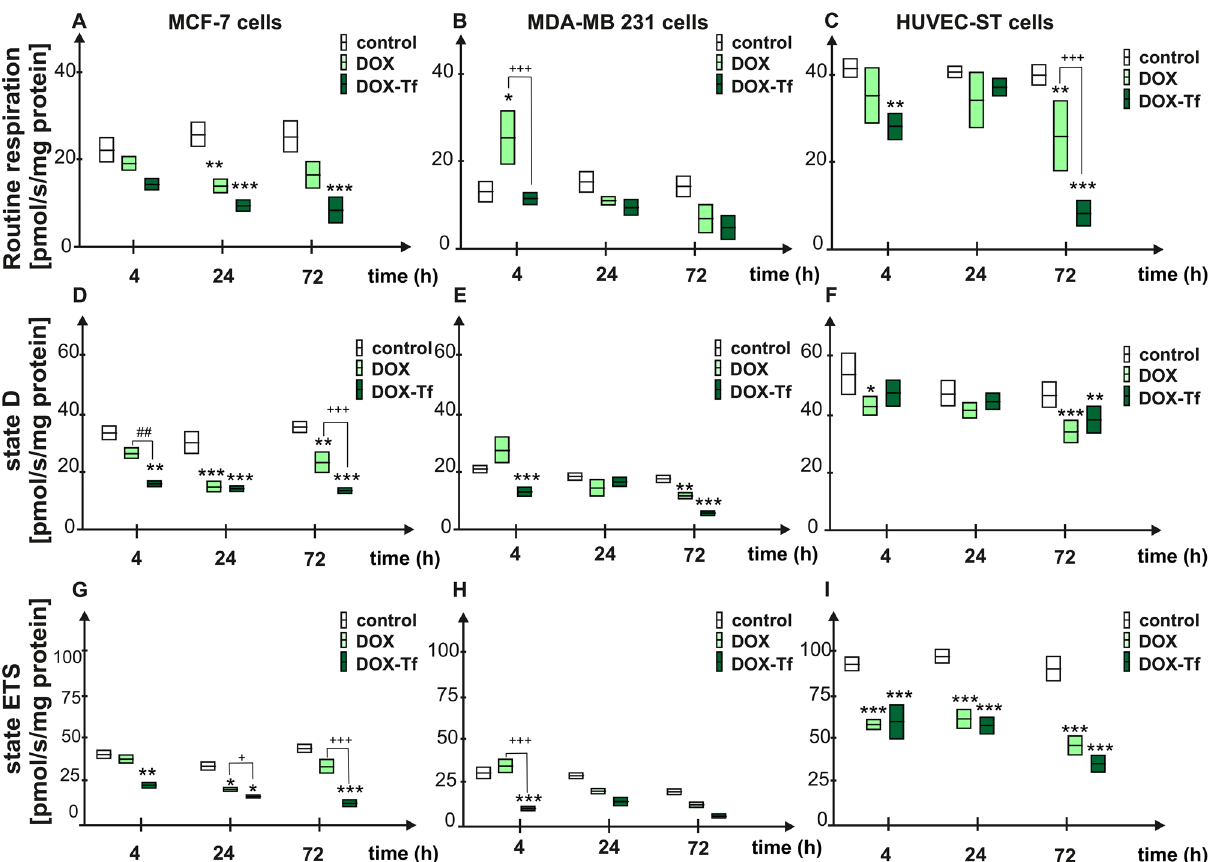
Figure 6. Mitochondrial respiration of MCF-7, MDA-MB 123 and HUVEC-ST cells after incubation with DOX–Tf. Data are expressed as pmol O 2 /s/mg protein in permeabilized cells measured after DOX and DOX–Tf treatment with IC 50 concentrations. The following mitochondrial states were evaluated: routine respiration (A–C) State D (D–F) and State ETS (G–I) after 4, 24 and 72 h incubation with DOX or DOX–Tf. Data were expressed as mean ± SD, n = 3. * p < 0.05, ** p < 0.01, *** p < 0.001 denote statistically significant changes in comparison with the control untreated cells; + p < 0.05, ++ p < 0.01, +++ p < 0.001 significant differences between samples incubated with DOX or